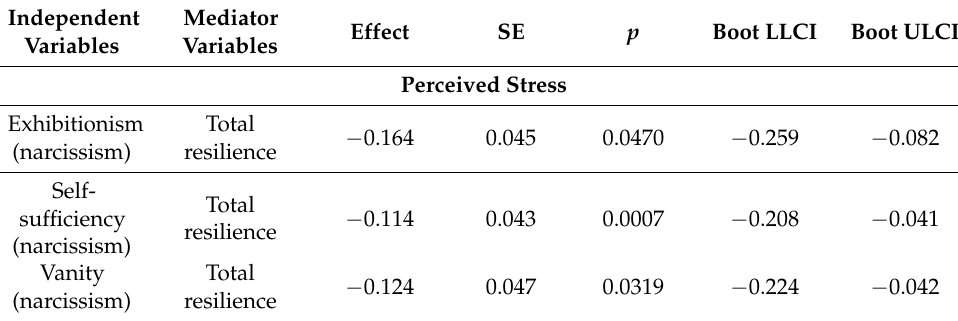
Table 5. Results of mediation analysis of the predictors of perceived